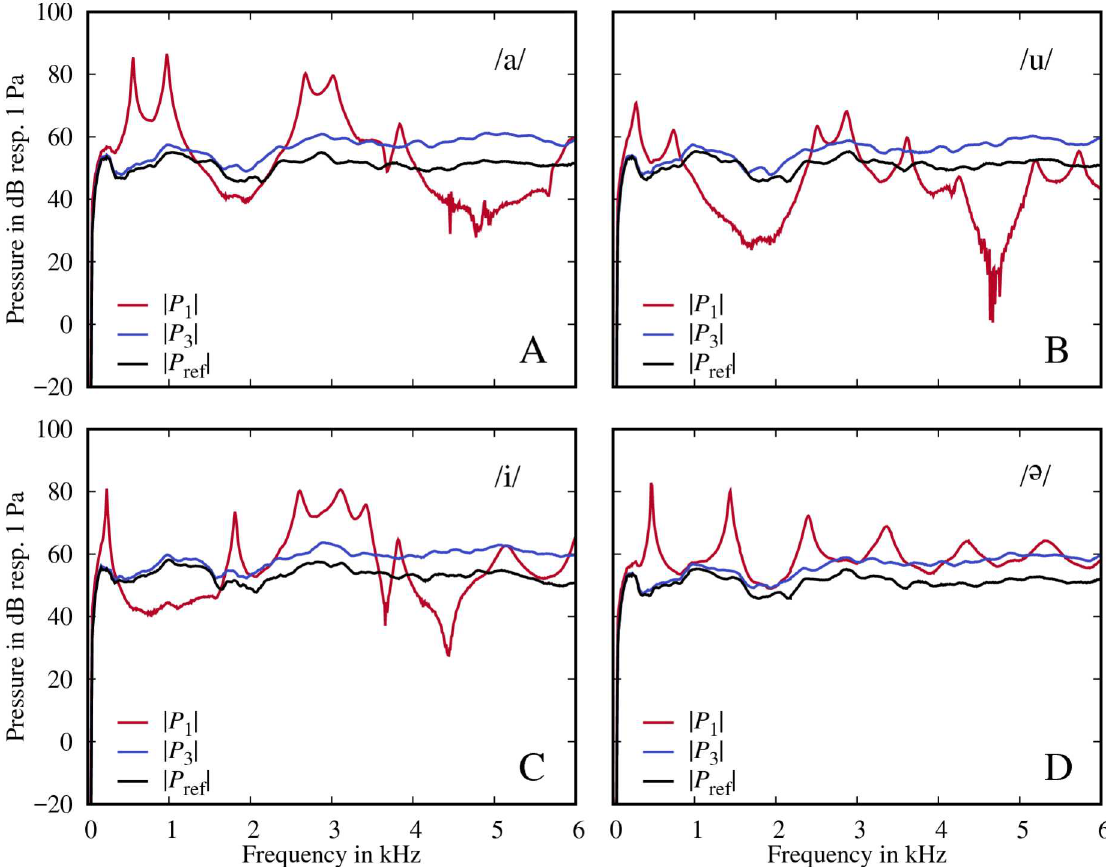
Fig 4. Measured signals. Spectra of pressure signals measured at the glottis ( P 1 ), in front of the closed mouth ( P 3 ) and without the models ( P ref ) for the models /a/ (A), /u/ (B), /i/ (C) and /e/